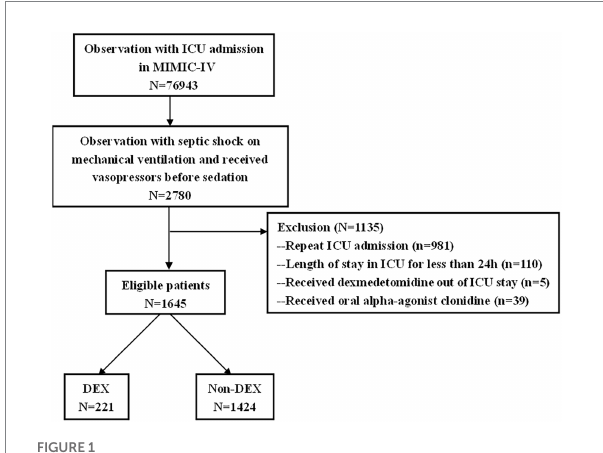
FIGURE 1 Study flowchart of eligible patients in MIMIC-IV database.